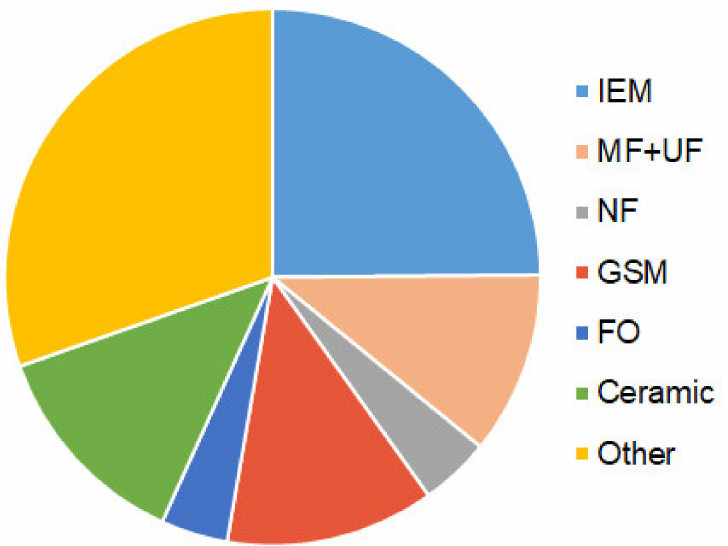
Figure 4. The share of publications in Scopus (reference dated 3 April 2022) devoted to the de- velopment of MBR and MFC equipped with ion-exchange (IEM), micro- (MF) and ultrafiltration (UF), nanofiltration (NF), gas-separation (GSM), osmotic (FO), and other membranes, including ceramic